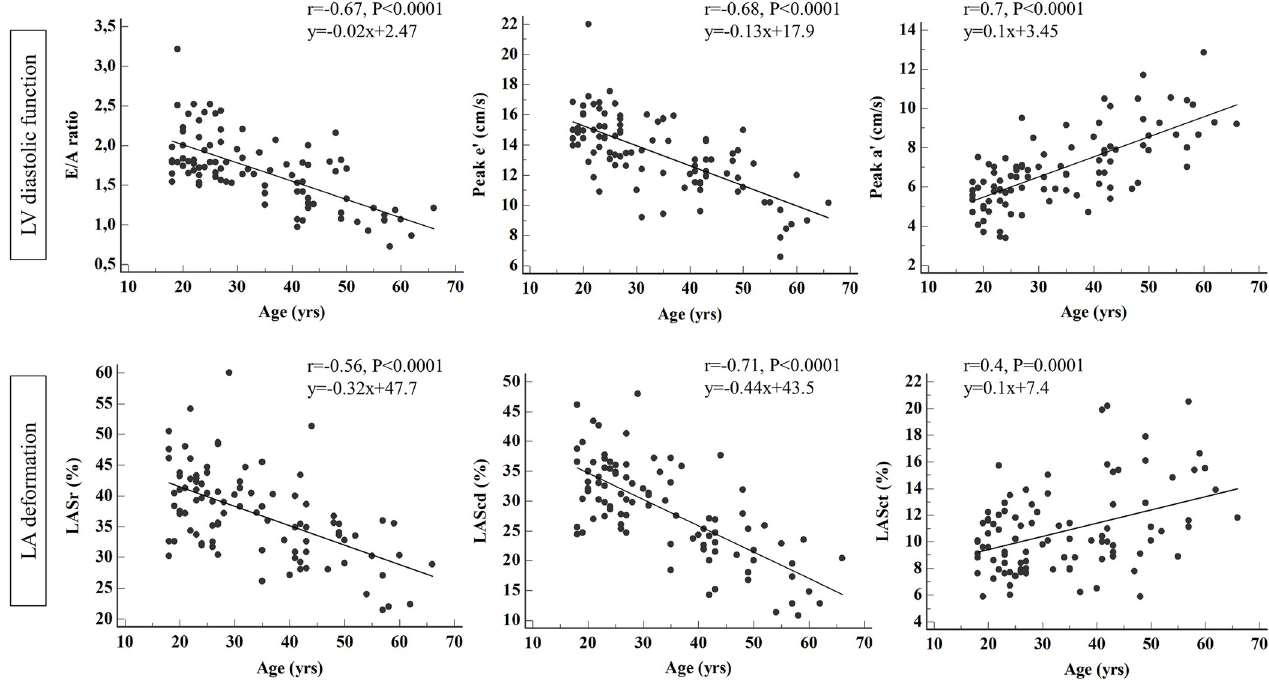
Fig 1. Linear regression analysis between age and left ventricular and atrial functional indices.